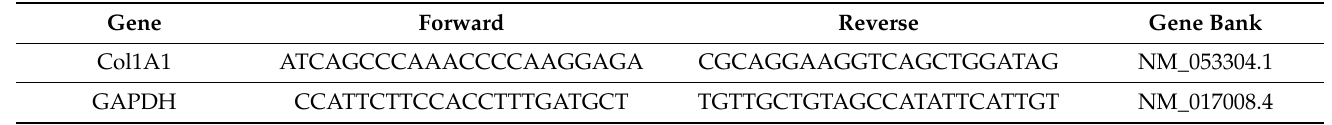
Table 1. Primers used for